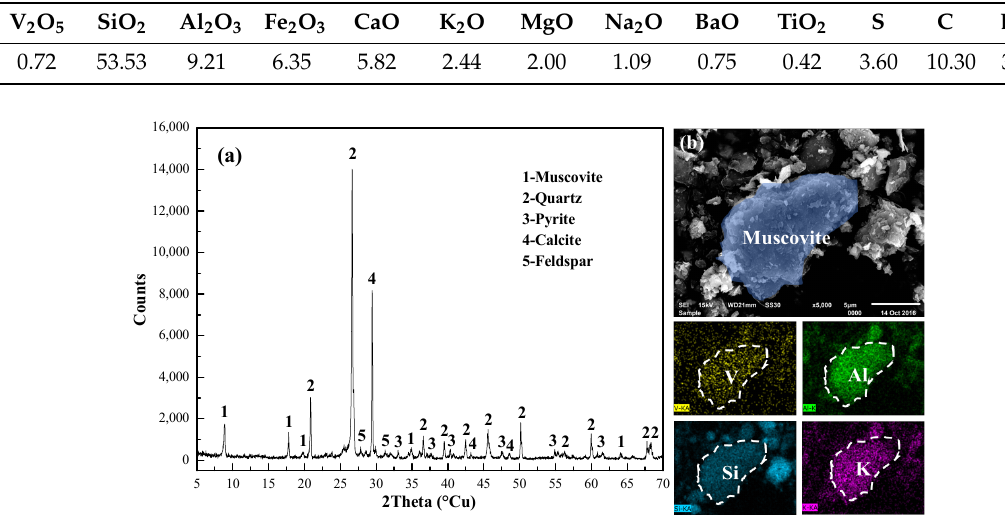
Table 1. Elemental compositions of the black shale (wt.%). Table 2. Vanadium valence distribution in the black shale (wt.%).